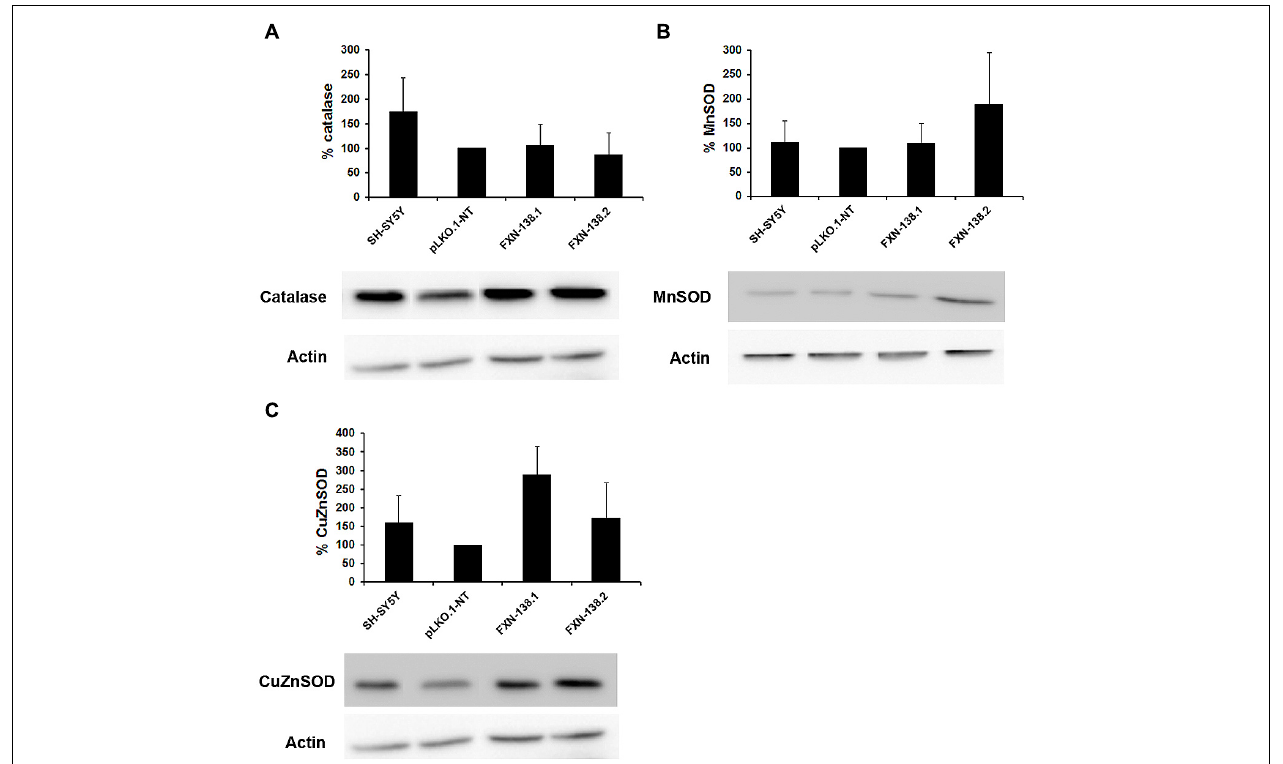
FIGURE 6 |Analysis of antioxidant enzymes. Western blots analyses of antioxidant enzymes were carried out. Once normalized the intensities, the protein levels of antioxidant enzymes are expressed as percentages versus